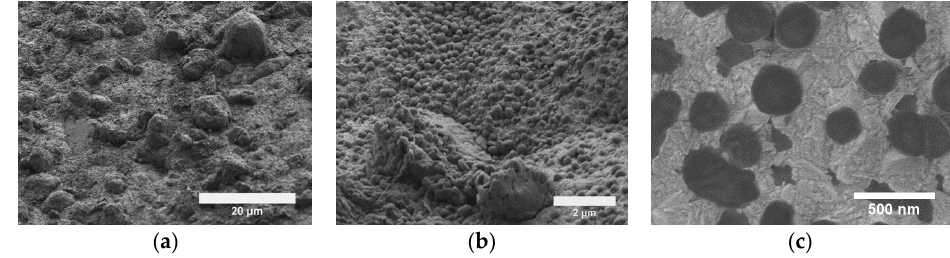
Figure 9. SEM micrographs of the nanocrystalline Ni-PTFE composite showing a lotus leaf-like morphology: ( a ) low magnification; ( b ) medium magnification; ( c ) high magnification.